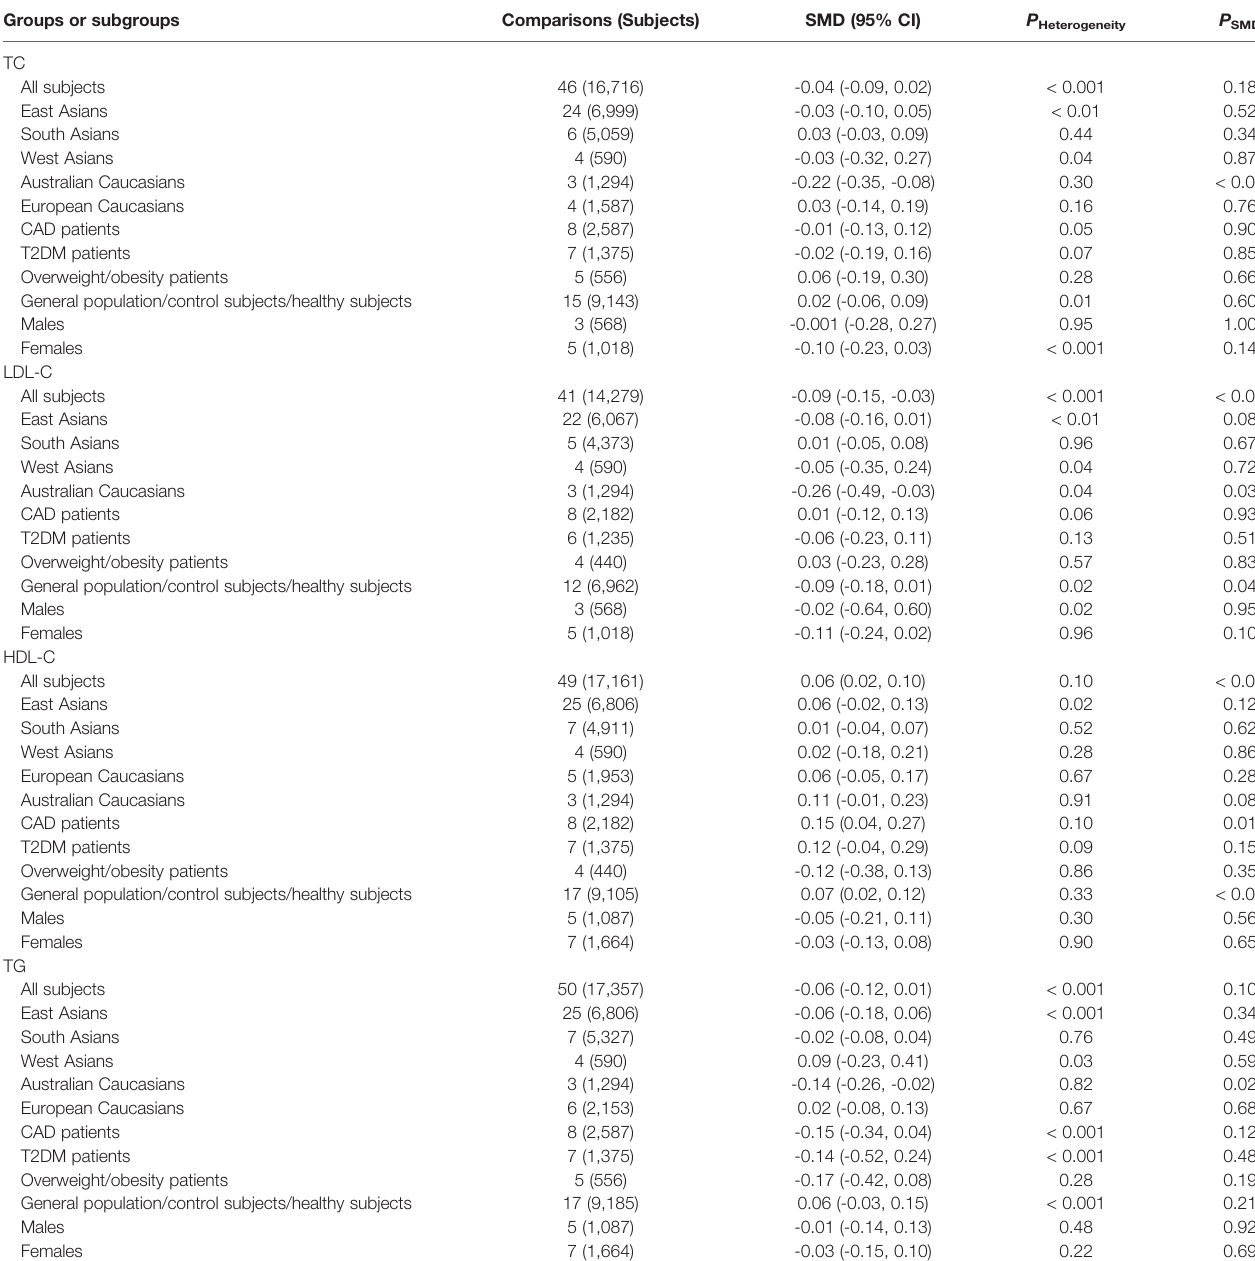
TABLE 4 | Meta-analysis between the rs3856806 polymorphism in PPARG and serum lipid levels. Groups or